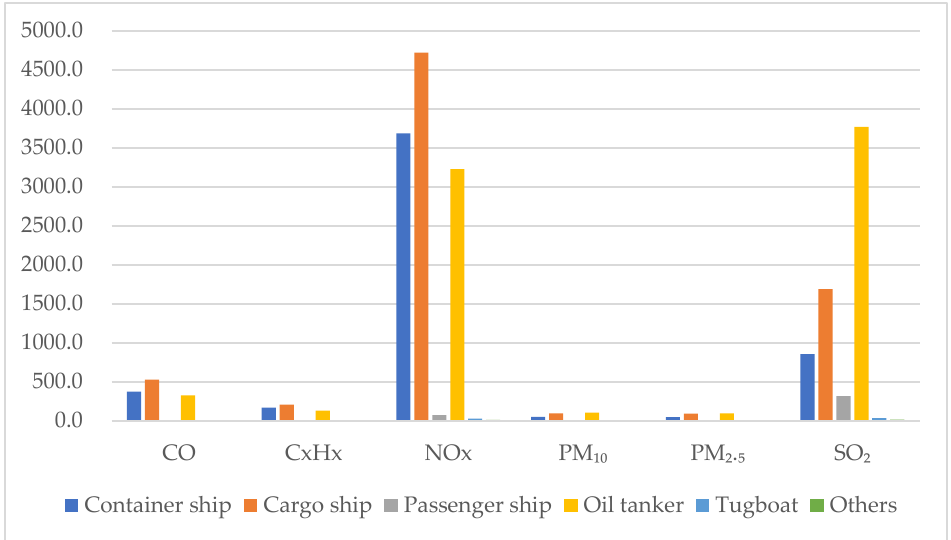
Figure 5. Comparison of total pollutant emissions from different types of ship (unit: ton).